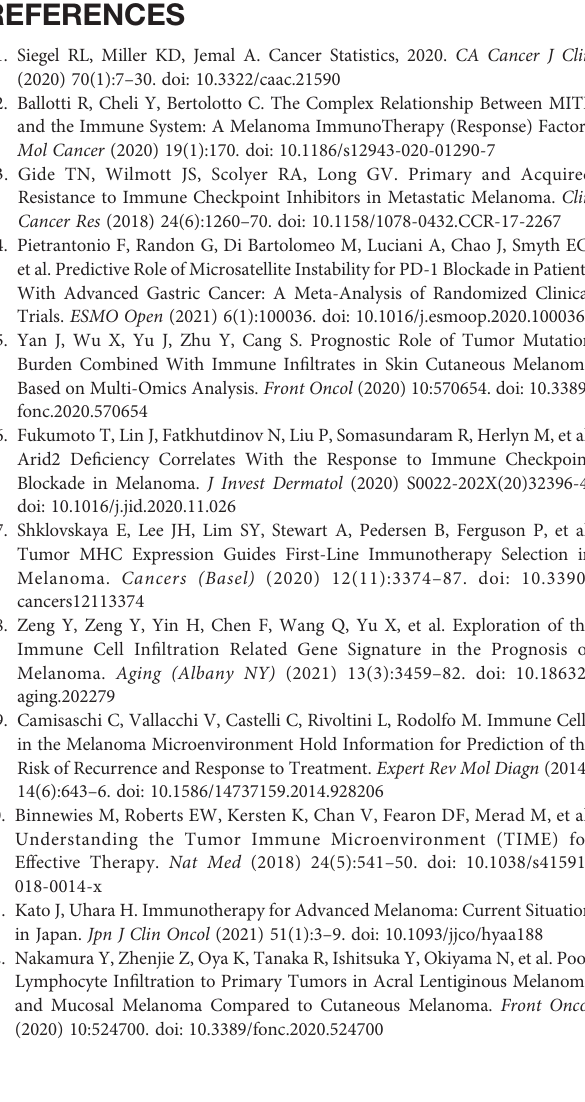
Supplementary Figure 1 | (A) Overview of study design. (B – E) Consensus matrixes (K=3-6) of ICI cluster for all melanoma sample. (F) Unsupervised clustering heatmap of immune cells in fi ltration for TCGA cohort. Rows represent tumor- in fi ltrating immune cells, and columns represent samples.